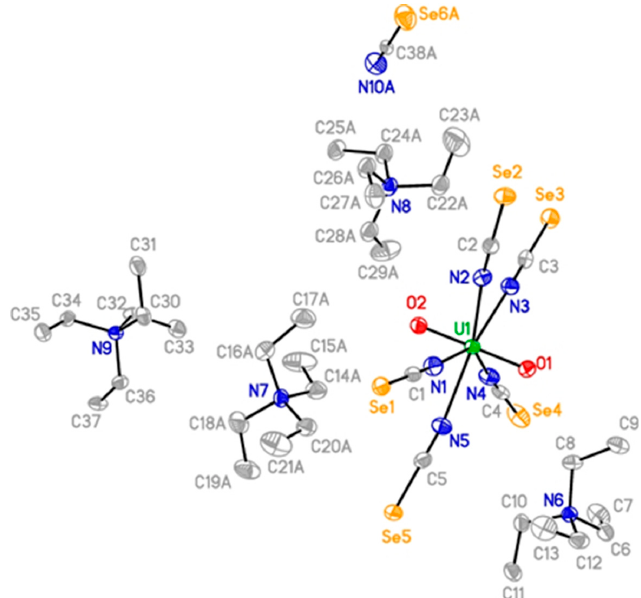
Figure 1. ORTEP plot of the structure of 2 refined with 70; 65; 55% occupancy for C14a–C21a; C22a– C29a; N10a–Se6a respectively. Thermal displacement shown at 50% occupancy and hydrogen atoms omitted for clarity. Selected bond lengths (Å): U(1)–O(1): 1.771(2); U(1)–N(1): 2.448(3); U(1)–N(2):